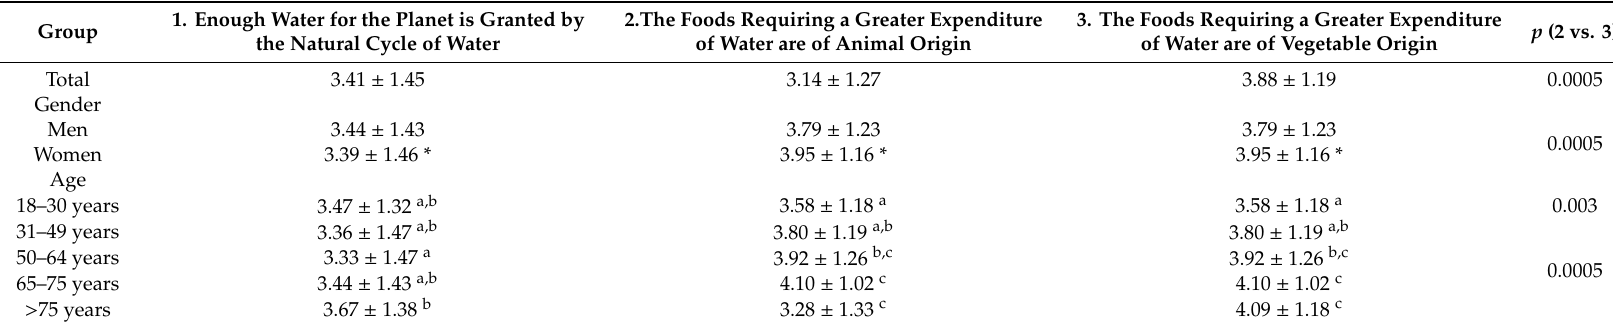
Table 4. Perceived importance of water-use in food production, in a scale 1–5 (1 = totally disagree; 5 = totally agree), in adult Spanish population, by gender and age